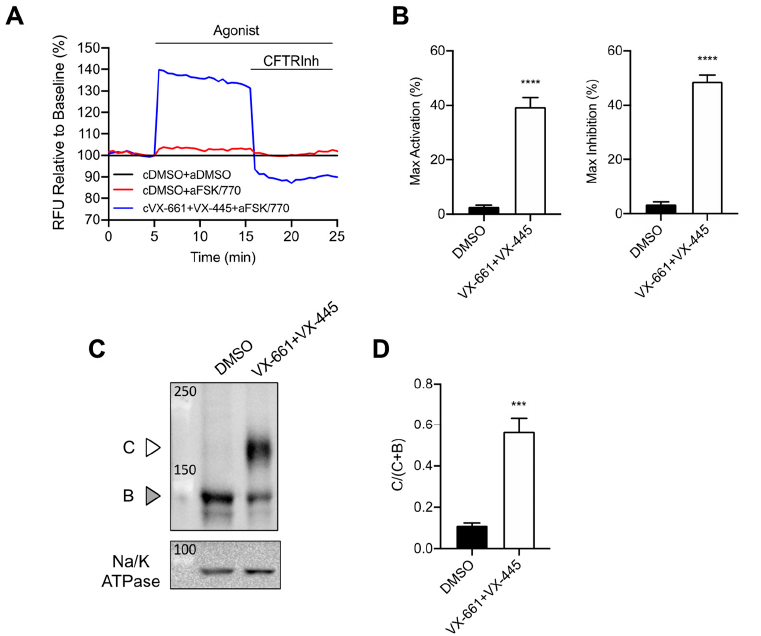
Figure 1. F508del-CFTR is rescued by VX-661 + VX-445 in CFBE F508del-CFTR cells. ( A ) Representative traces of F508del-CFTR dependent chloride efflux by membrane depolarization assay. CFBE-F508del cells were treated with 0.1% DMSO or 3 μ M VX-661+ 3 μ M VX-445 for 24 h at 37 °C. Acute DMSO for cells chronic pre-treated with DMSO (cDMSO + aDMSO), acute 10 μ M forskolin (FSK) + 1 μ m VX-770 (FSK/770) for cells chronic pre-treated with DMSO (cDMSO + aFSK/770), or acute FSK/770 for cells chronic pre-treated with VX-661 + VX-445 (cVX-661 + VX-445 + aFSK/770) were added as agonists. ( B ) Bar graphs show the mean (±SEM) of maximal activation of F508del-CFTR after stimulation by 10 μ M FSK+ 1 μ M VX-770 (left) or maximal inhibition by 10 μ M CFTRInh172 (right) ( n = 4 biological replicates with 4 technical replicates for each one). ( C ) Immunoblots of steady-state expression of F508del-CFTR in CFBE F508del-CFTR cells after 24 h treatment with 0.1%